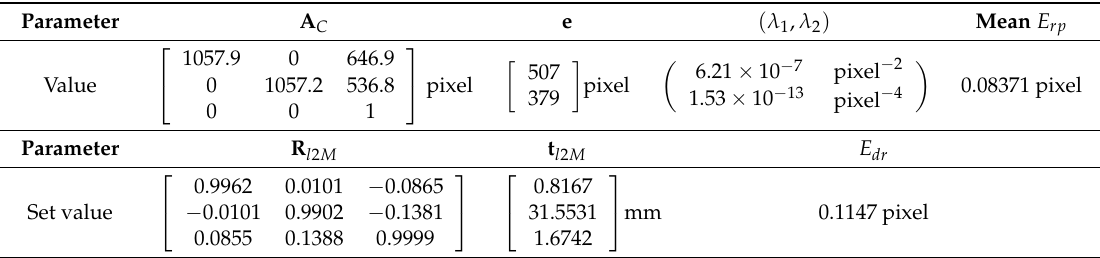
Table 6. System parameters and evaluation error when checkerboard is close to